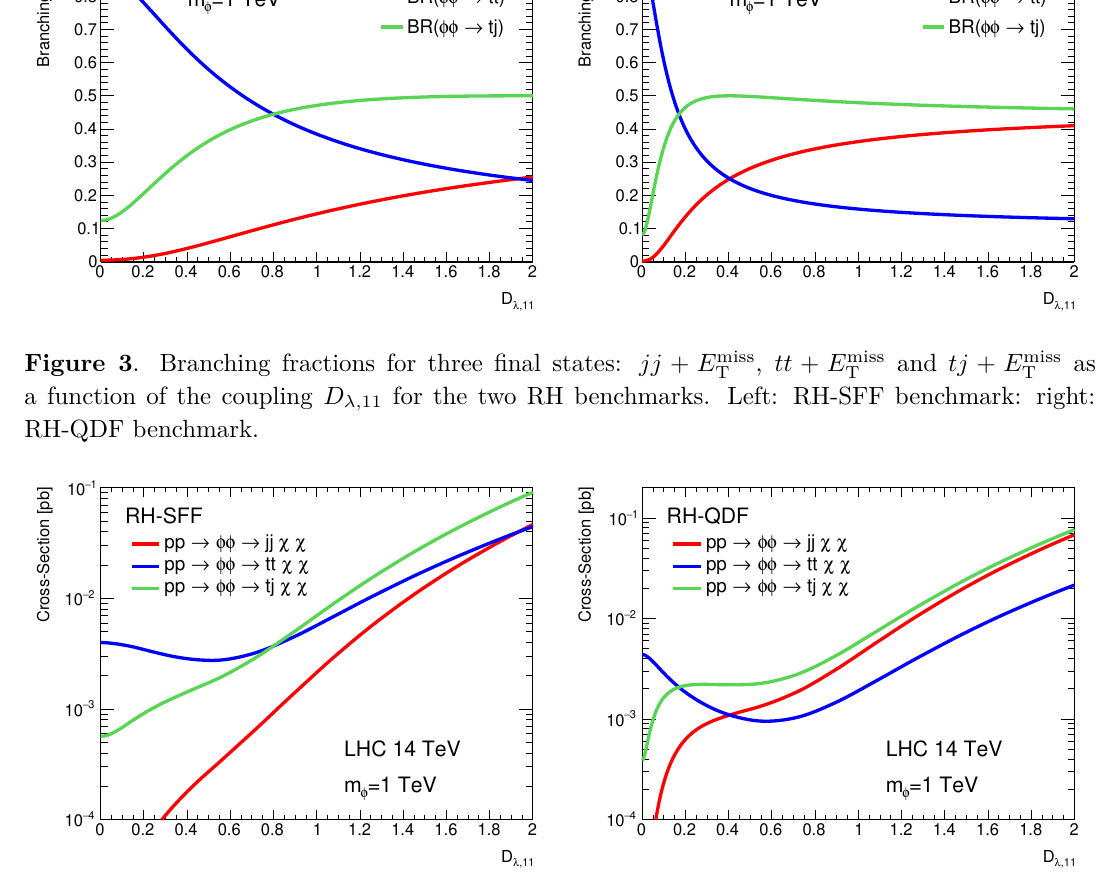
Figure 4 . Production cross-section for the different final states resulting from pair production of mediators at a 14 TeV LHC for the two RH benchmarks as a function of D right: RH-QDF. The assumed mediator mass is 1